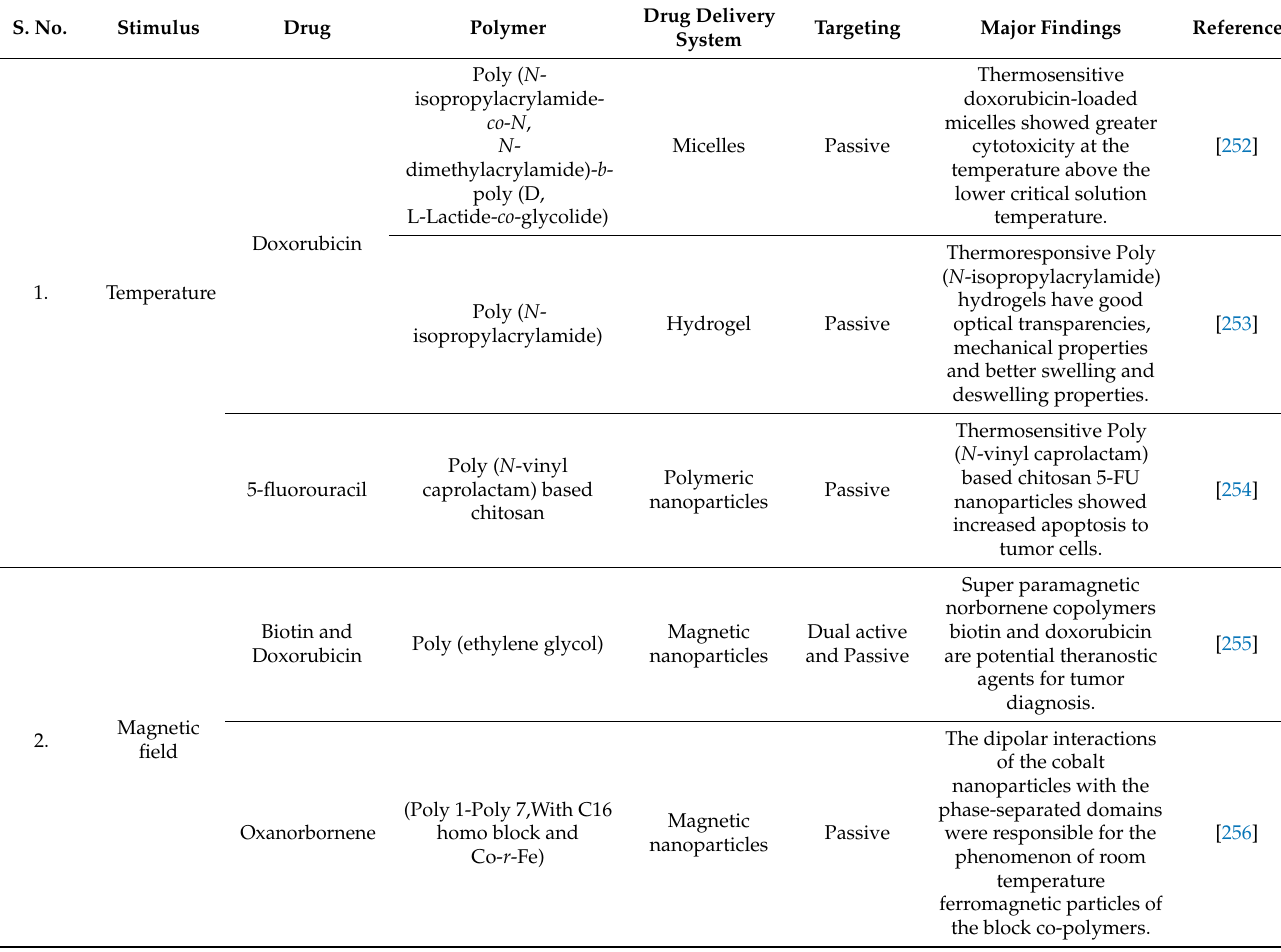
Table 7. Stimuli-Responsive Carrier/Polymer-based Drug Delivery Systems for Cancer Chemotherapy. S.